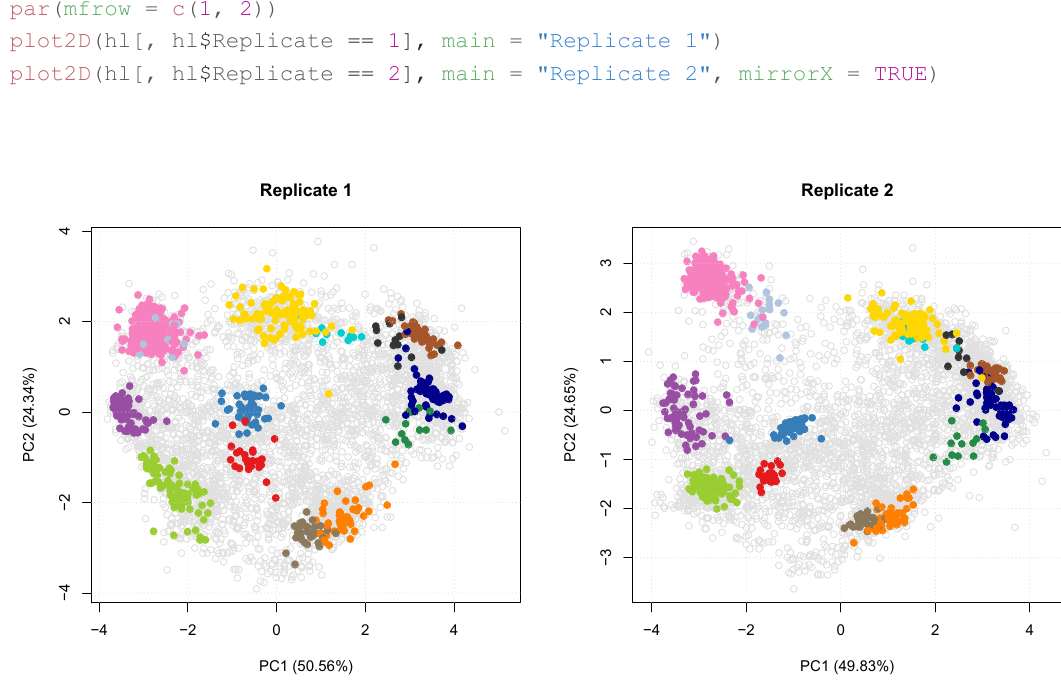
Figure 11. PCA plots of replicates 1 and